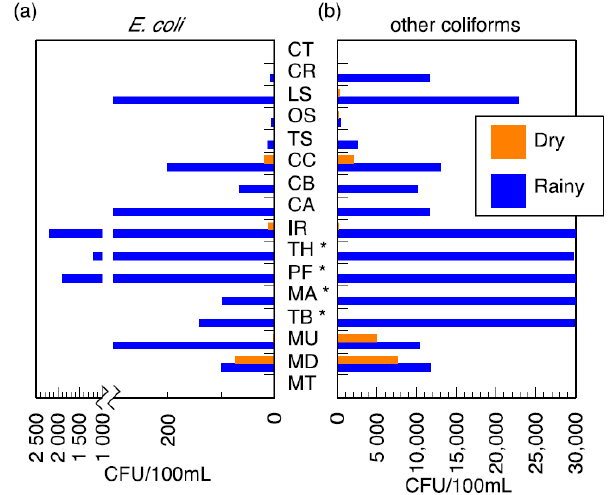
4 Figure 4. Membrane filtration results for ( a ) E. coli and ( b ) other coliforms. Data are presented for